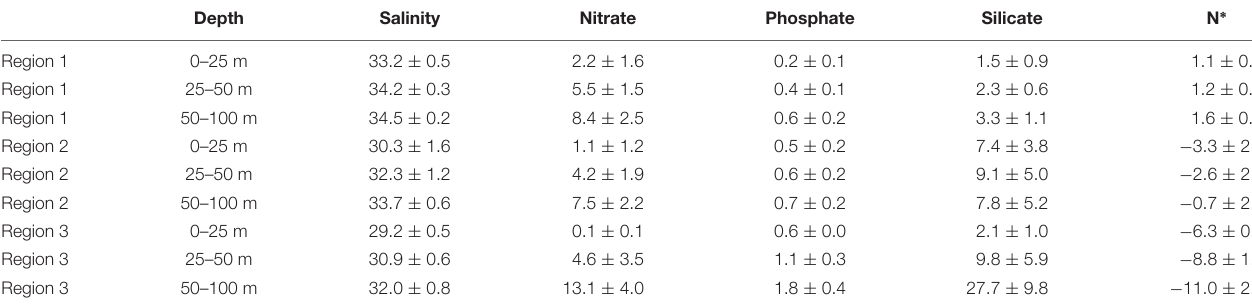
TABLE 1 | Salinity, concentrations of macronutrients and N ∗ (mean ± standard deviation). Depth Salinity Nitrate